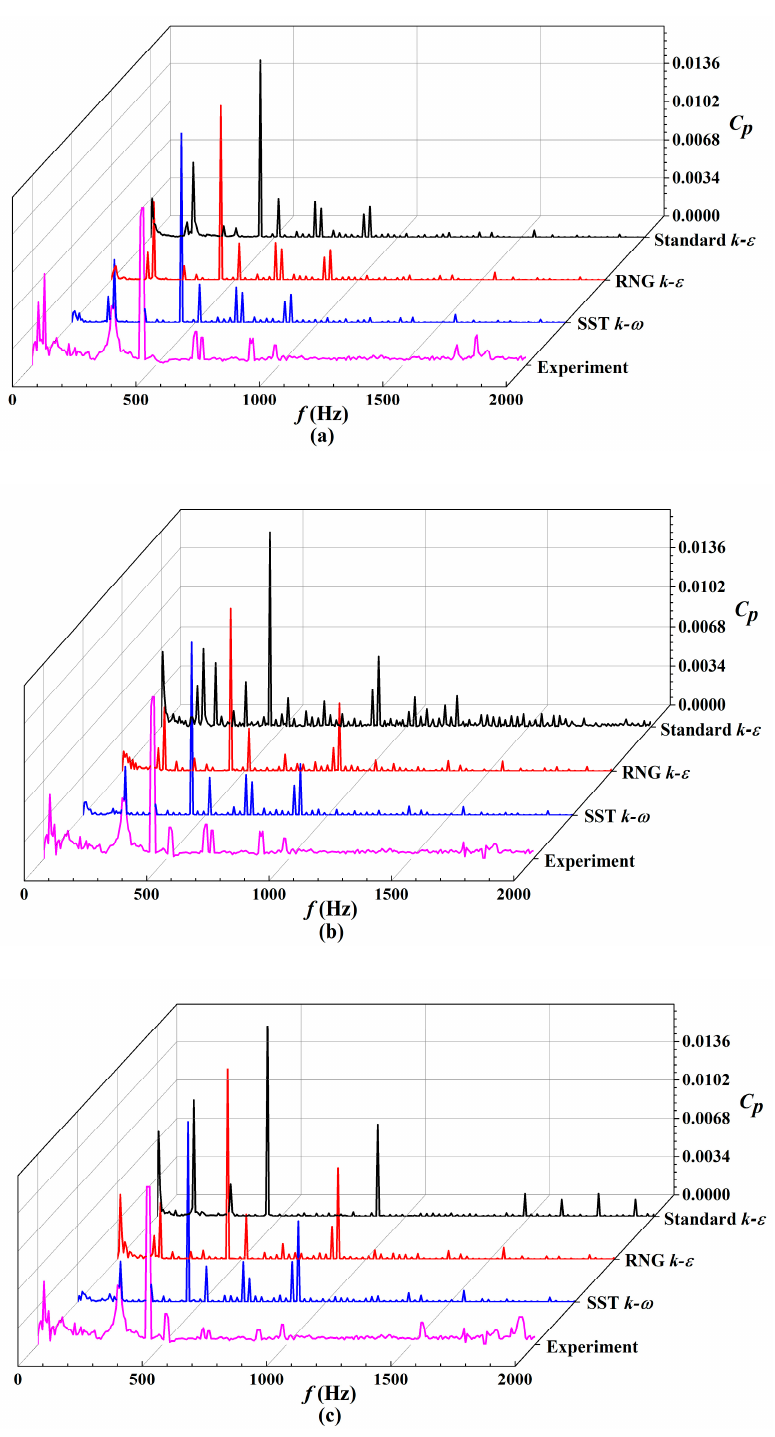
Figure 7. Comparison of pressure pulsation between simulation and experiment for ( a ) 0.8 of the design flow rate ( Q d ) , ( b ) 1.0 Q d , and ( c ) 1.2 Q d .